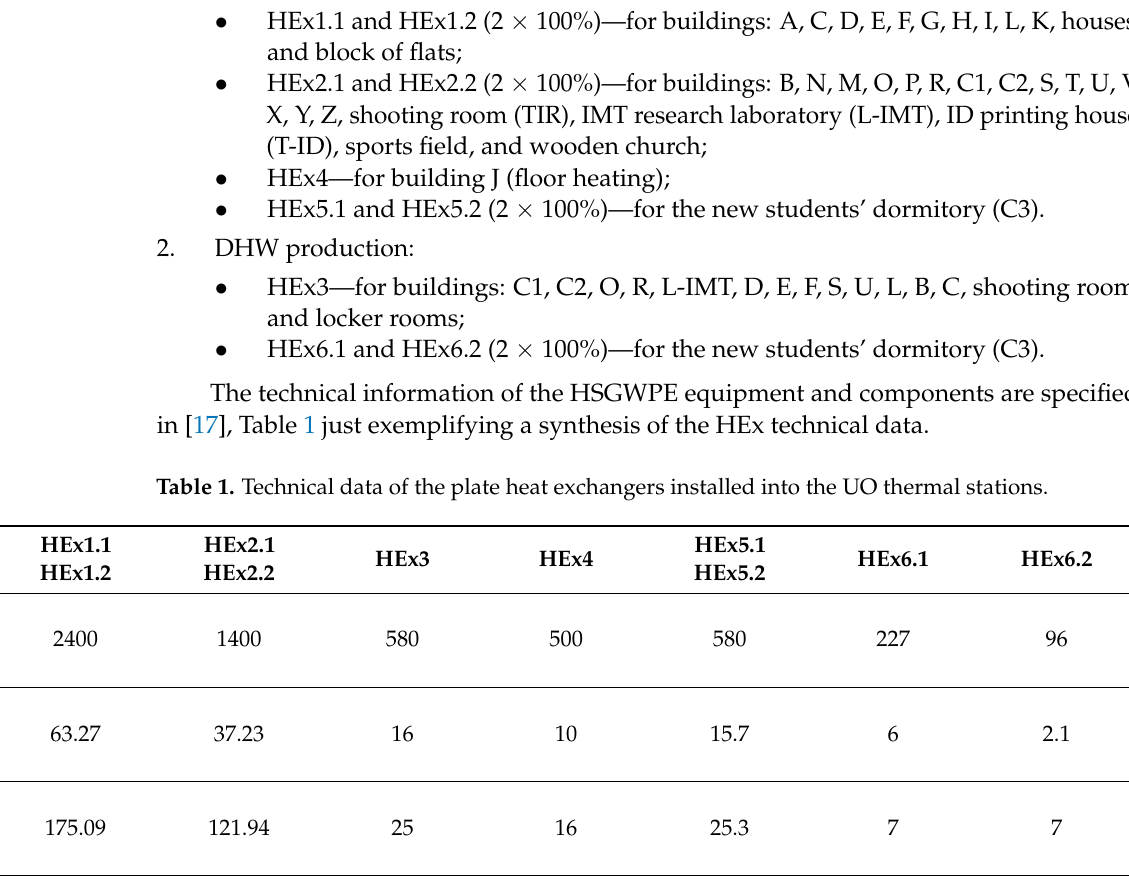
Table 1. Technical data of the plate heat exchangers installed into the UO thermal stations.